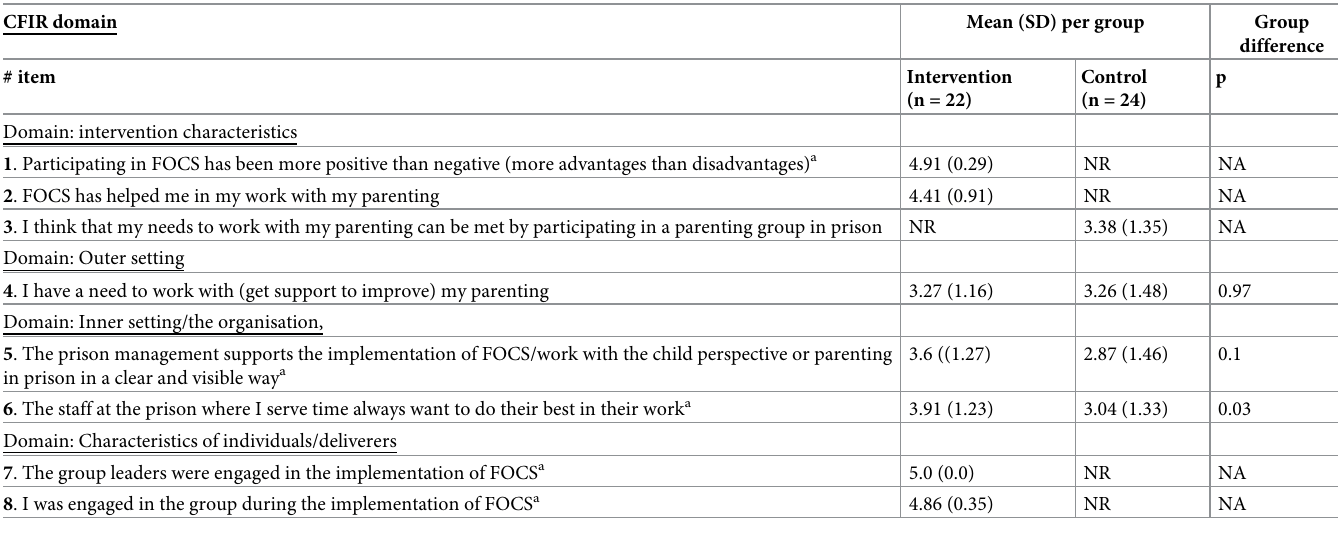
Table 2. Results of analysis on quantitative data, descriptive statistics, and group